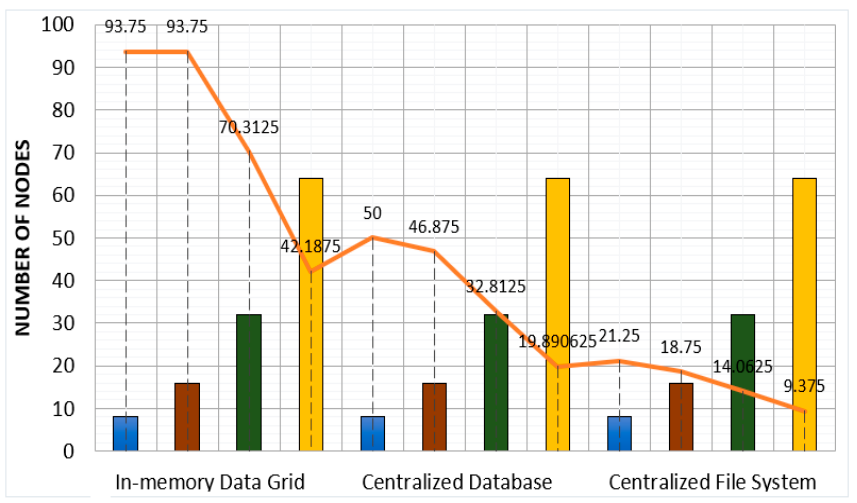
Figure 5. The scalability degradation limits.